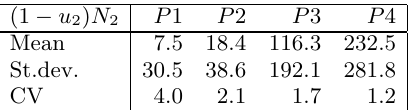
Table 4: Simulated means, standard deviations, and coefficients of variation for Example 3.